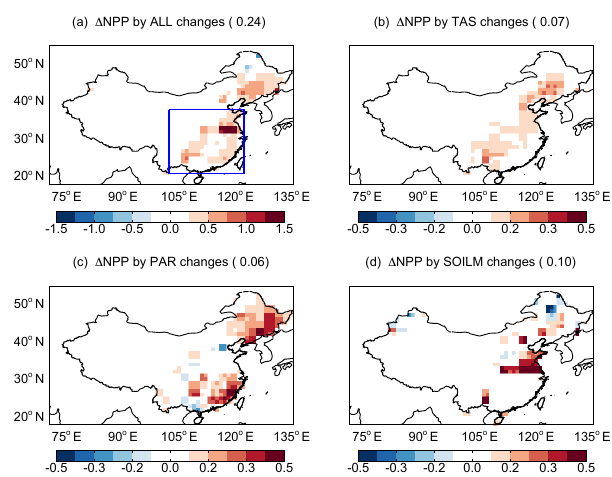
Figure 8. Decomposition of aerosol-induced changes in summer NPP. Changes in NPP are caused by aerosol-induced changes in (b) surface air temperature, (c) photosynthetically active radiation (PAR), (d) soil moisture, and (a) the combination of above three effects. Simulations are performed with the offline YIBs vegetation model driven with meteorological forcings simulated with the ModelE2-YIBs climate model (Table S3). The NPP responses to PAR include the DRF effects. The maximum color scale for panel (a) is 1.5 while the others (b–d) are 0.5. The average NPP perturbation over the box domain in a is shown in the bracket of each title. Only the significant changes ( p <0.05) are shown. Units: gCm − 2 day − 1